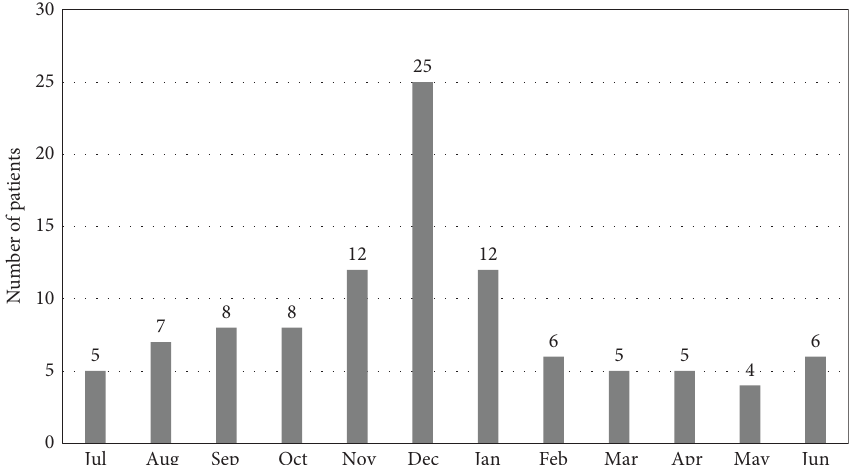
Figure 1: Distribution of community-acquired pneumonia due to human rhinovirus according to the month of hospital admission. Admissions occurred perennially, with a peak from November to